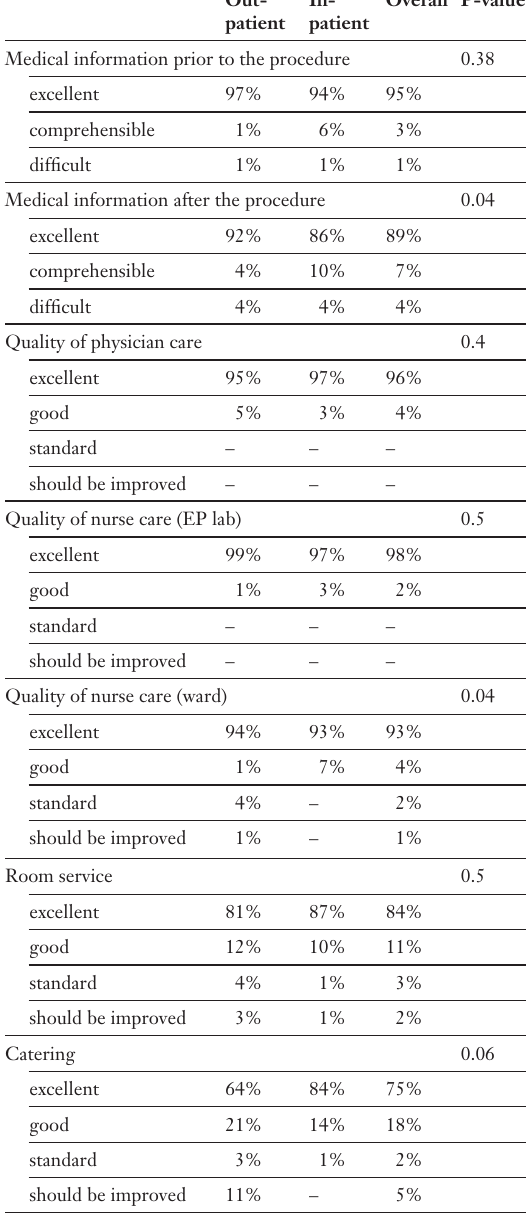
Out- In- Overall P-value patient patient